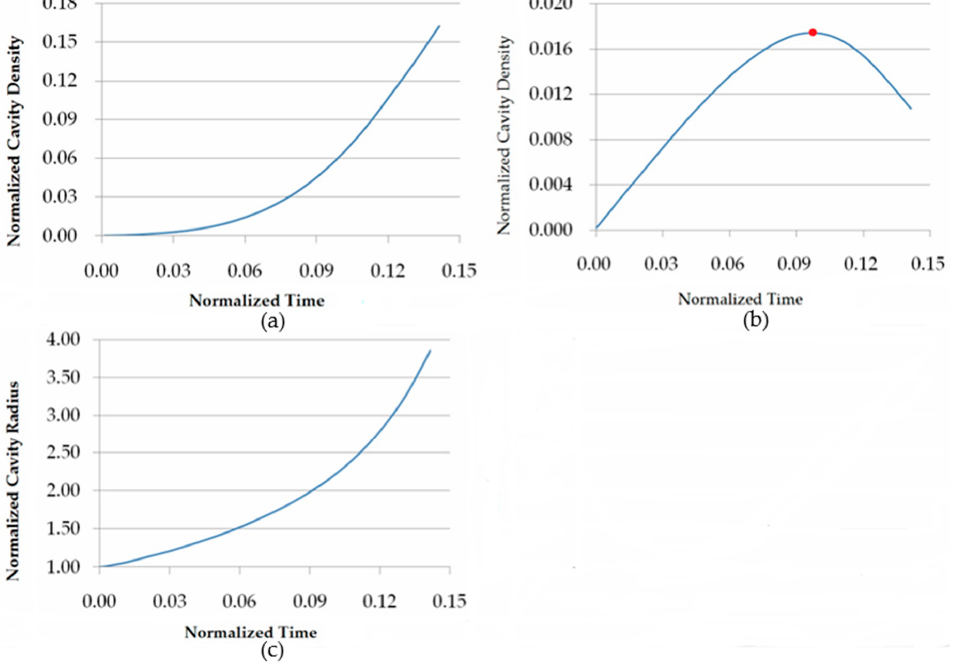
Figure 5. Cavitation evolution of these two important indicators. ( a ) The change of the damage variable β versus the normalized time. ( b ) The change of the cavity density (normalized) versus the normalized time. ( c ) The change of the average radius a (normalized) versus the normalized time. The rupture time is 0.142 (normalized), the maximum value of the β is 0.162, the final value of ρ